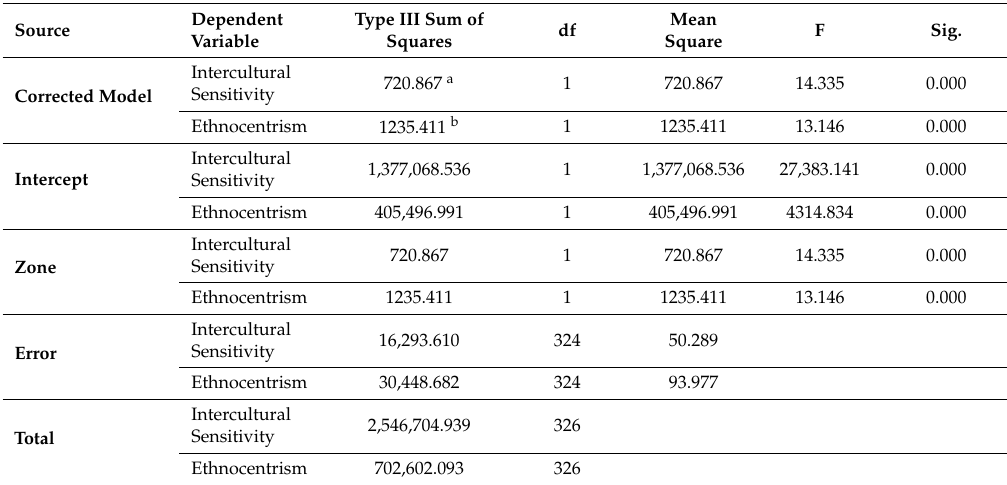
Table 18. The interaction between Intercultural Sensitivity and Ethnocentrism and the status of exposure to individuals from a di ff erent country or culture from the theology